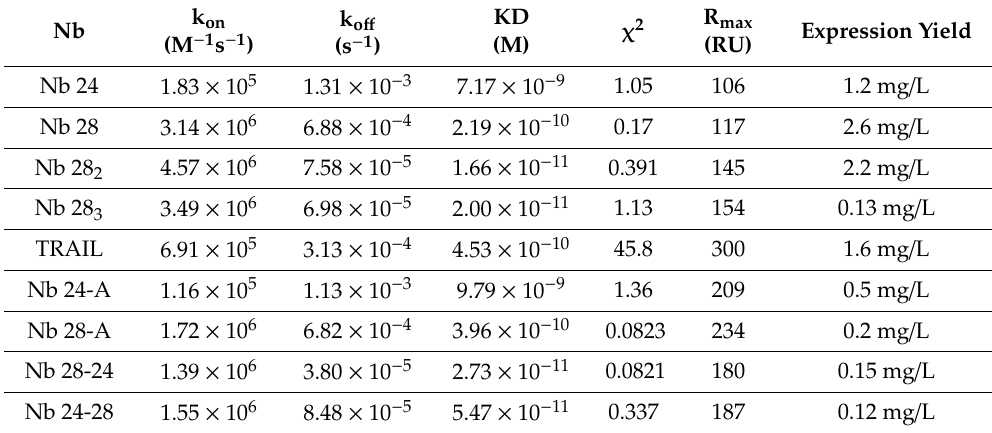
Table 1. Kinetic parameters of Nb–DR5 interactions measured by surface plasmon resonance